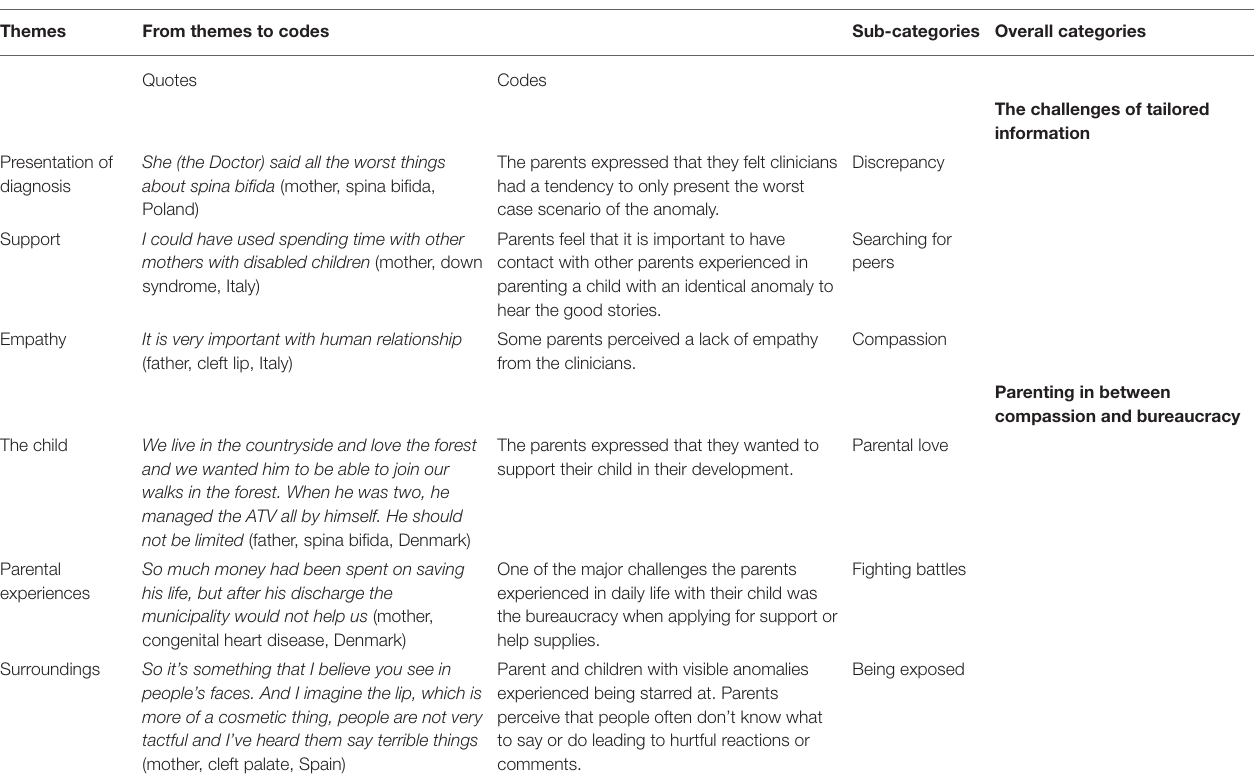
TABLE 2 | Systematic text condensation of